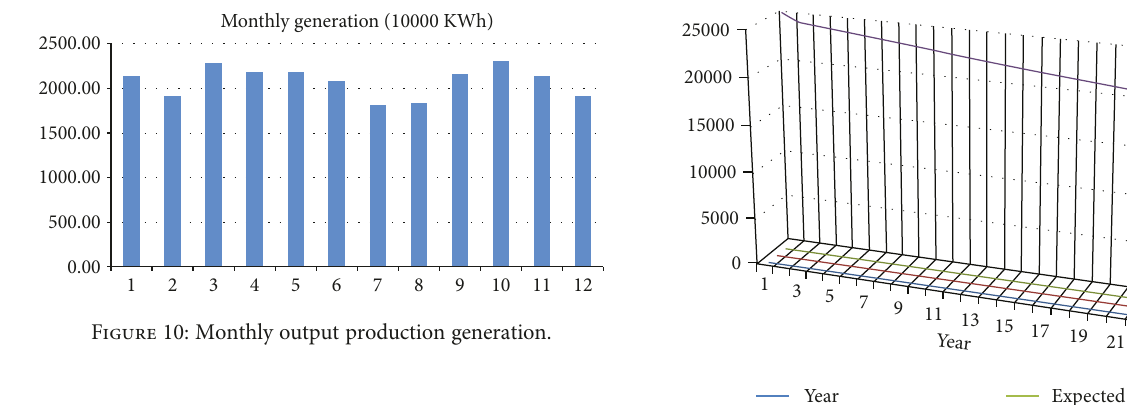
Table 10: Power generating prediction and net output [10000kWh/year] for one-year period.